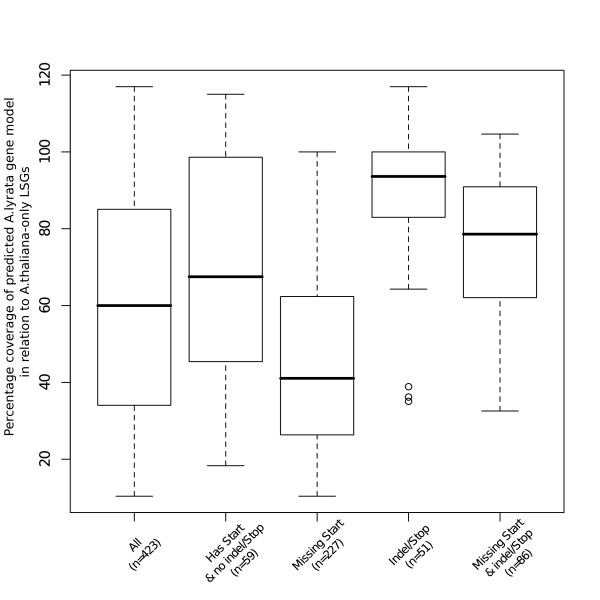
Distribution of percentage coverage for LSG CDS vs. Arabidopsis lyrata intergenic region alignments. Where percentage coverage is greater than 100% indicates a gap in the alignment in the LSG, indicating an indel in the LSG in Arabidopsis thaliana.